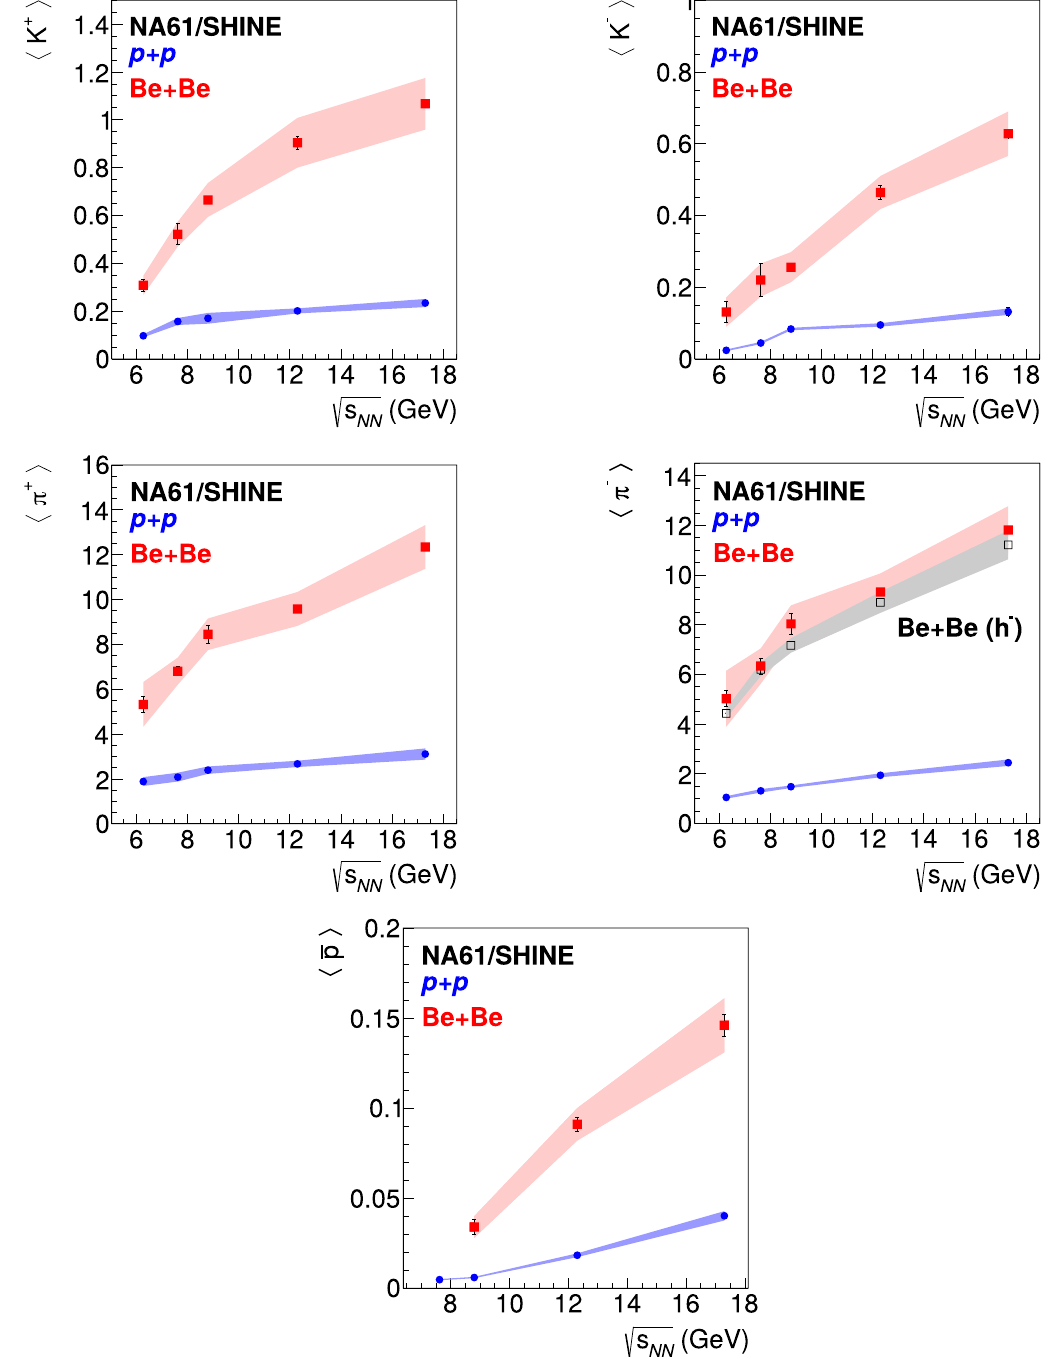
Fig. 32 Collision energy dependence of mean multiplicities of K + , K − , π + , π − , protons and antiprotons produced in the 20% most cen- tral Be+Be collisions. Results from inelastic p+p interactions [8,9] are plotted for comparison. Both statistical (vertical bars) and systematic uncertainties (shaded bands) are shown. Gray points and band corre-